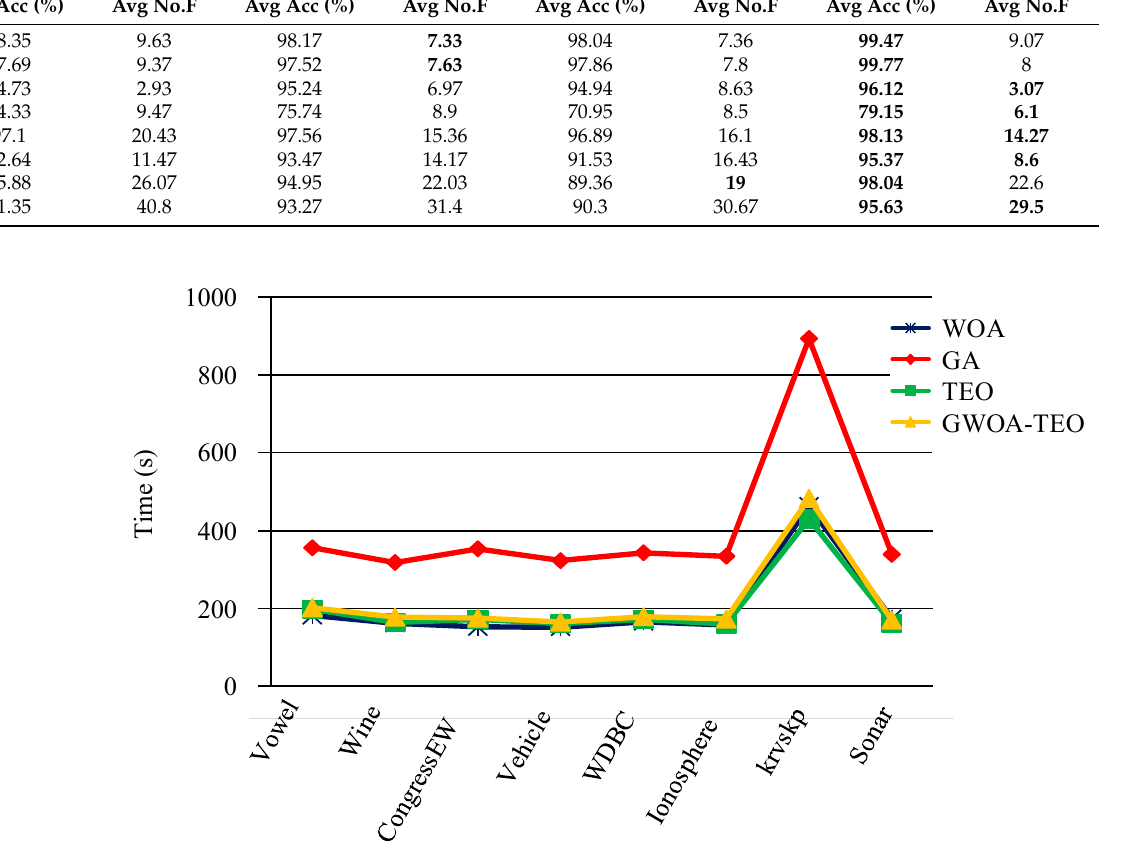
Figure 6. Convergence curves for the algorithms in case study 2.